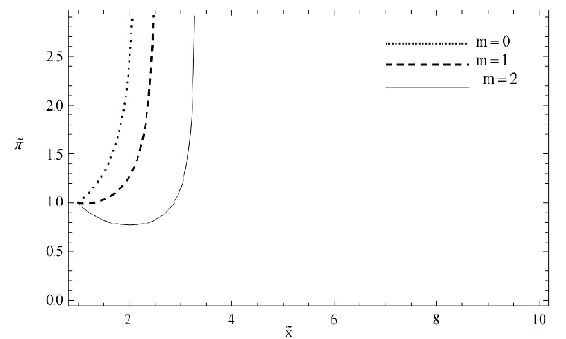
Figure 5. The growth of shock strength ( γ = 5/3.